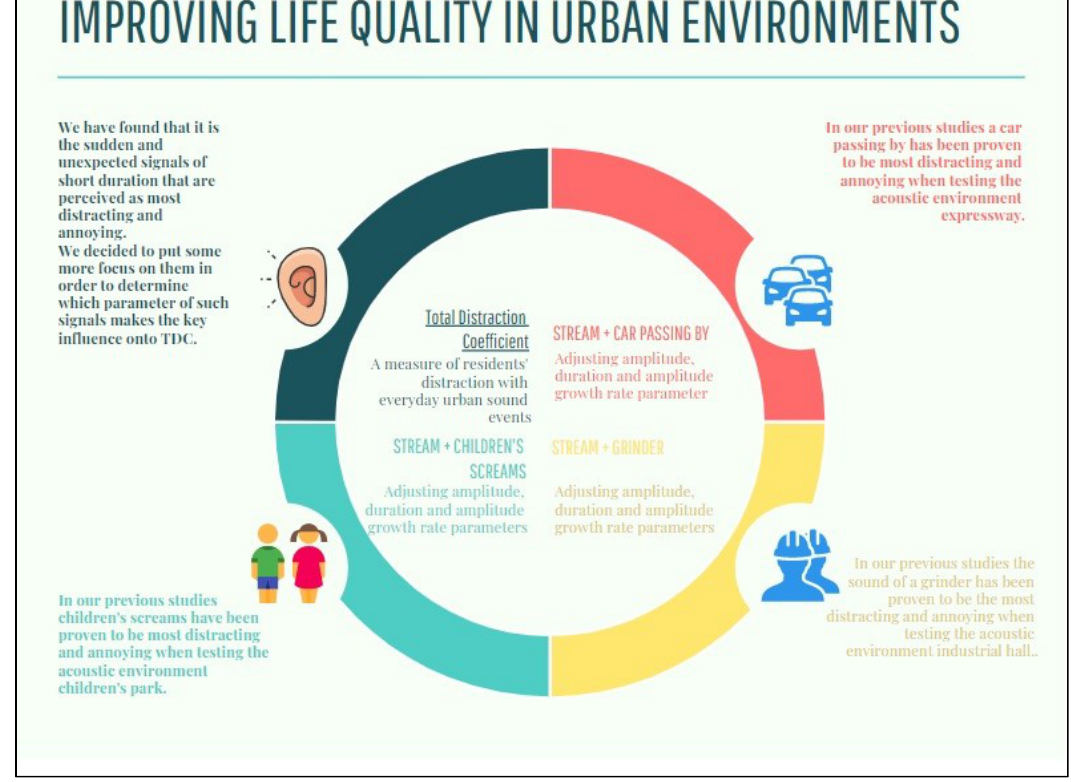
Figure 2. Main idea of how to improve the life quality in urban environments (from an acoustic point of view).